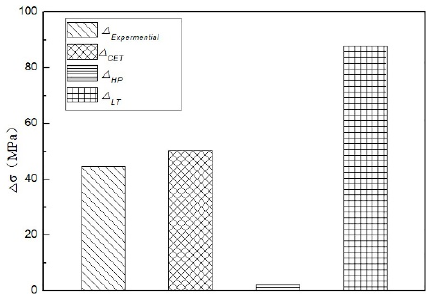
Figure 11. Comparison of the theoretical contribution for yield strength of composite with different strengthening mechanisms .